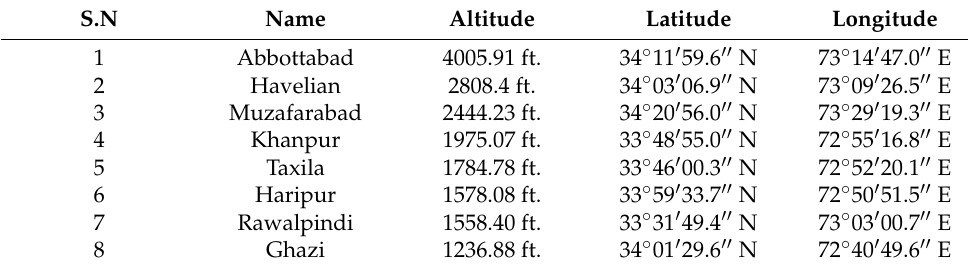
Table 1. Regions sorted by the altitude and